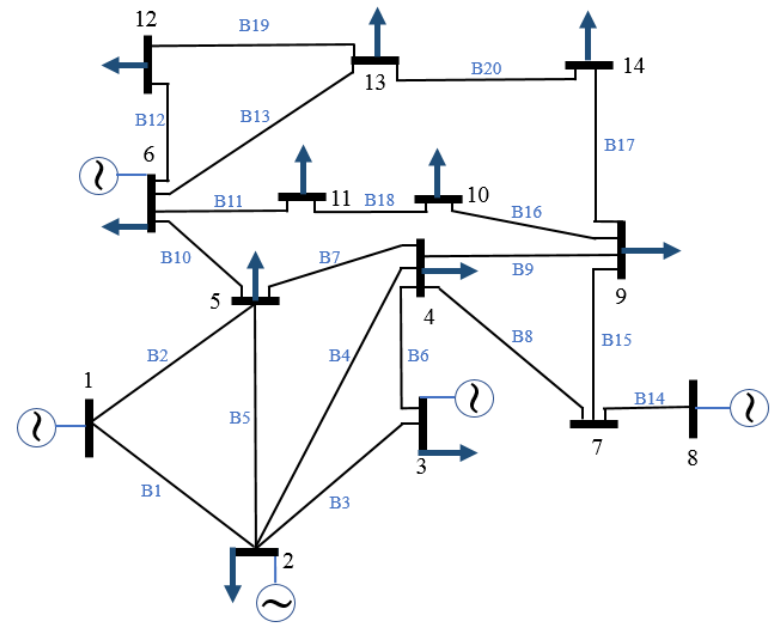
Figure 4. IEEE 14 bus test system ( Case 14) diagram indicating generators and loads positions as well as branches with their